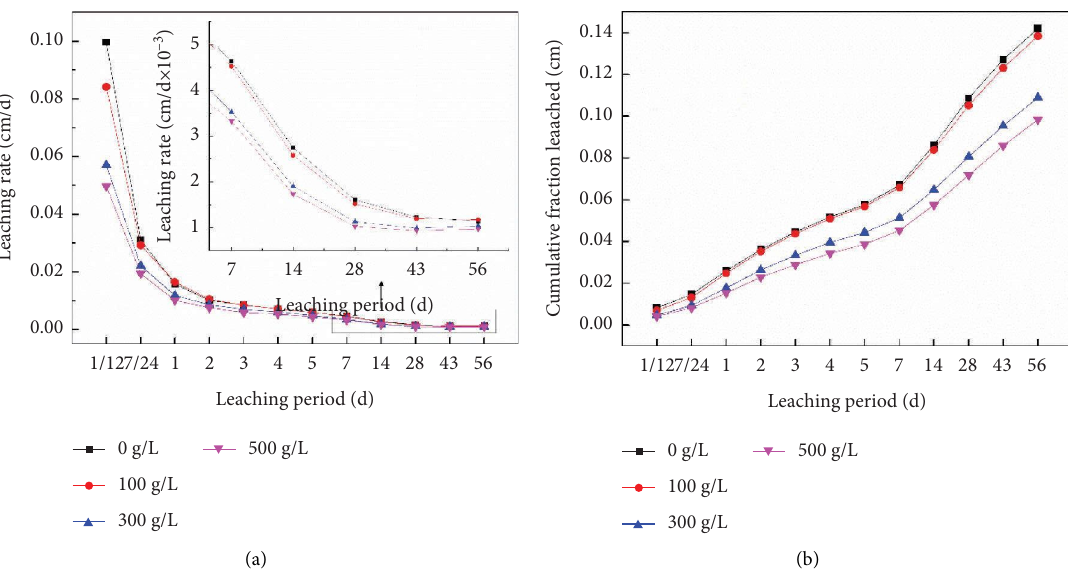
Figure 20: Te leaching curves of Cs + in the SFCM containing diferent concentrations of sodium nitrate at a sodium hydroxide content of 5%: (a) LF; (b)